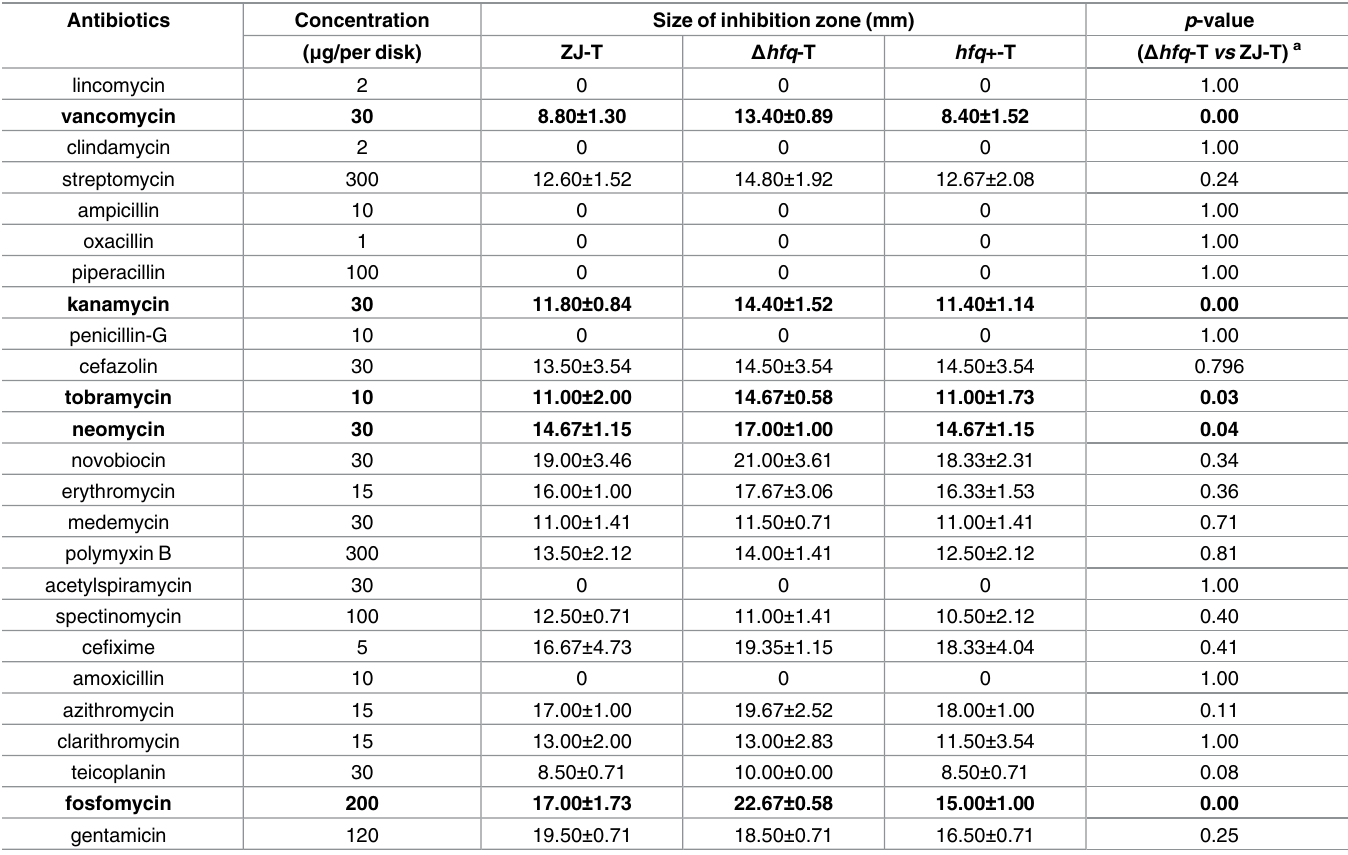
Table 4. Antibiotic resistance of ZJ-T, 4 hfq -T and hfq +-T.